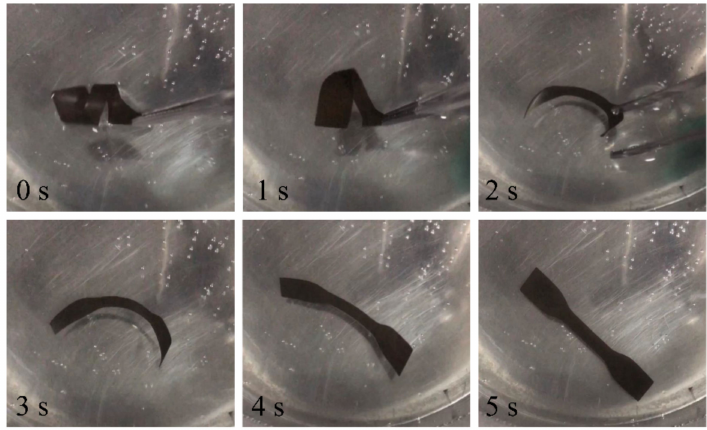
Figure 15. Photos of PWPU 5000 shape recovery in water at 70 ◦